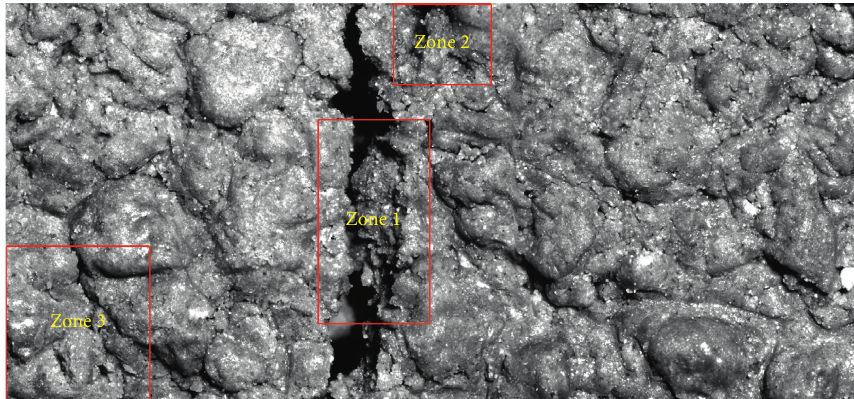
Figure 13: The processed image with large field.